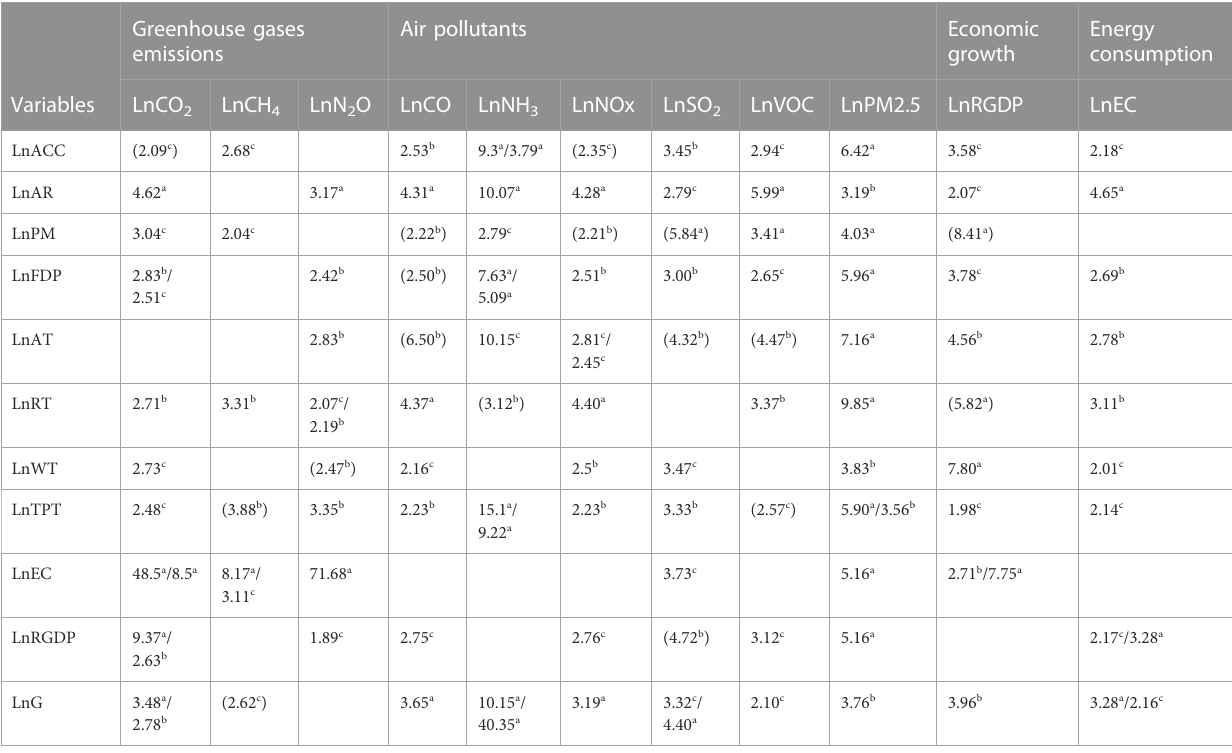
TABLE 7 Granger